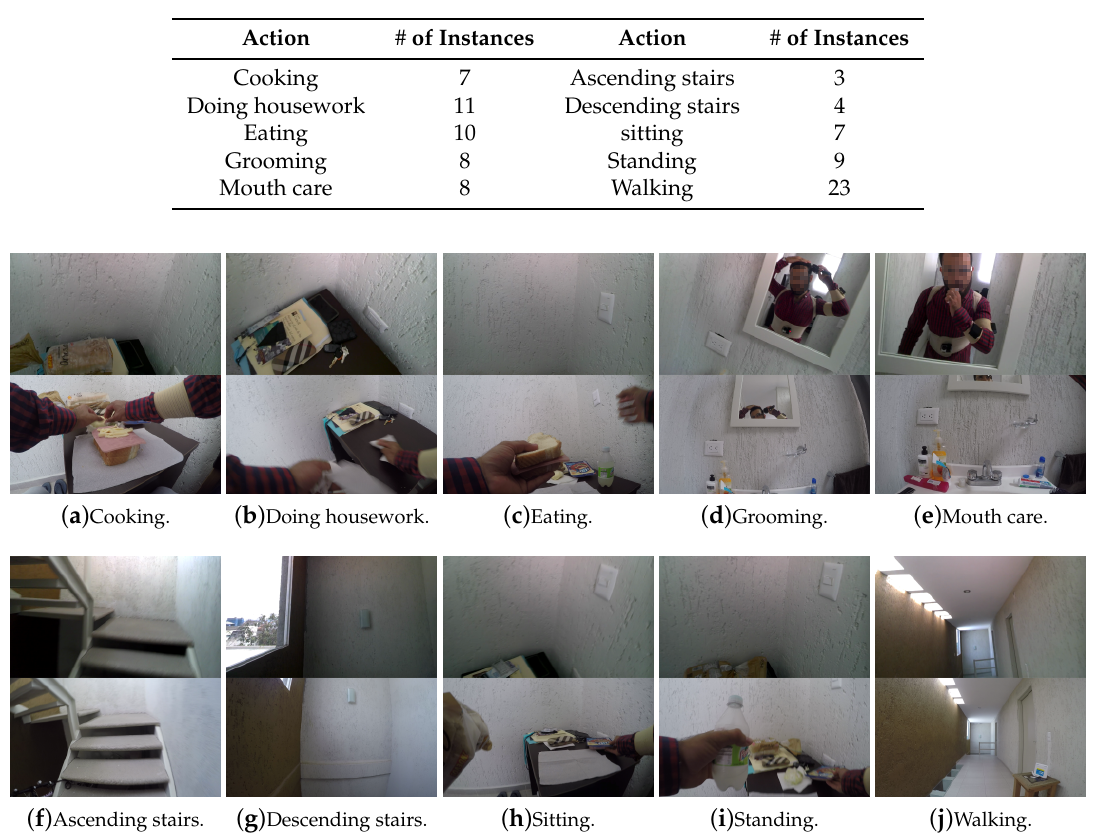
Table 1. Distribution of instances according to the actions performed by five subjects in their daily living environments.